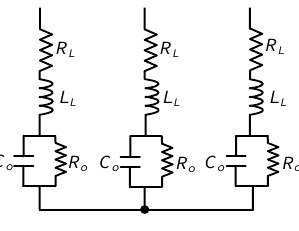
Figure 6. Three-phase load circuit. Table 2. Load parameters.